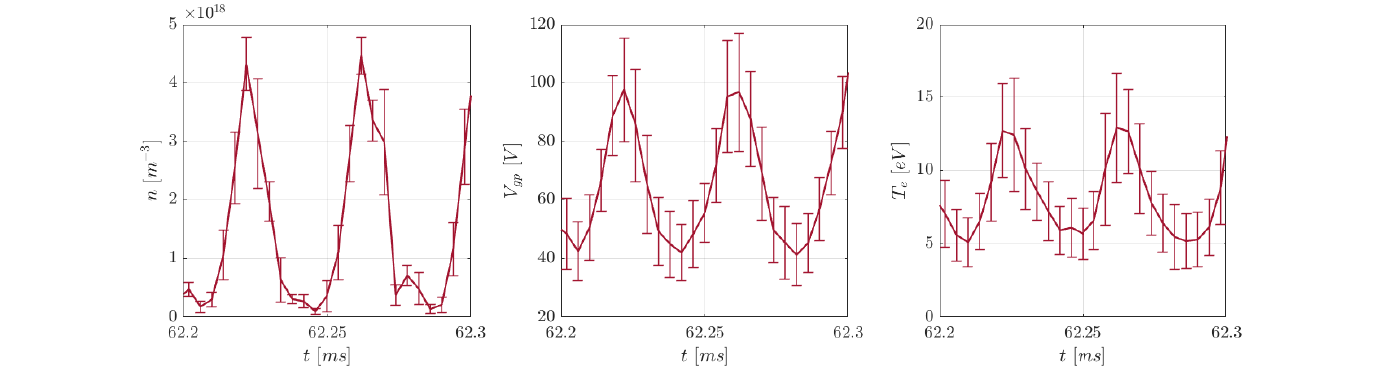
Figure 4. Example of plasma properties